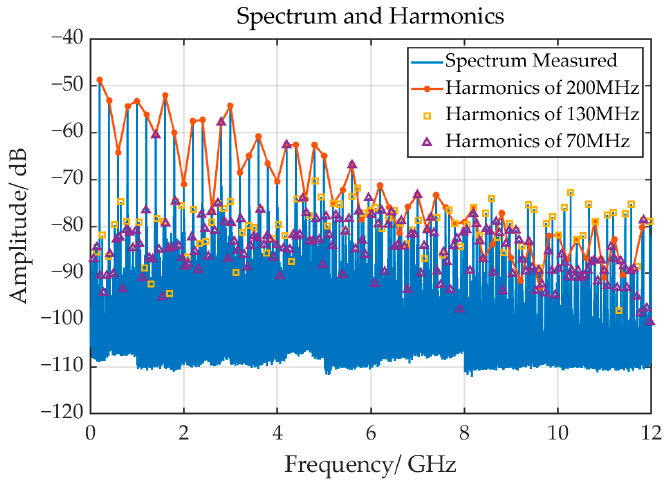
Figure 14. The spectrum measured above port 6 and the harmonics of signal transmitted from port 5 to port 6.